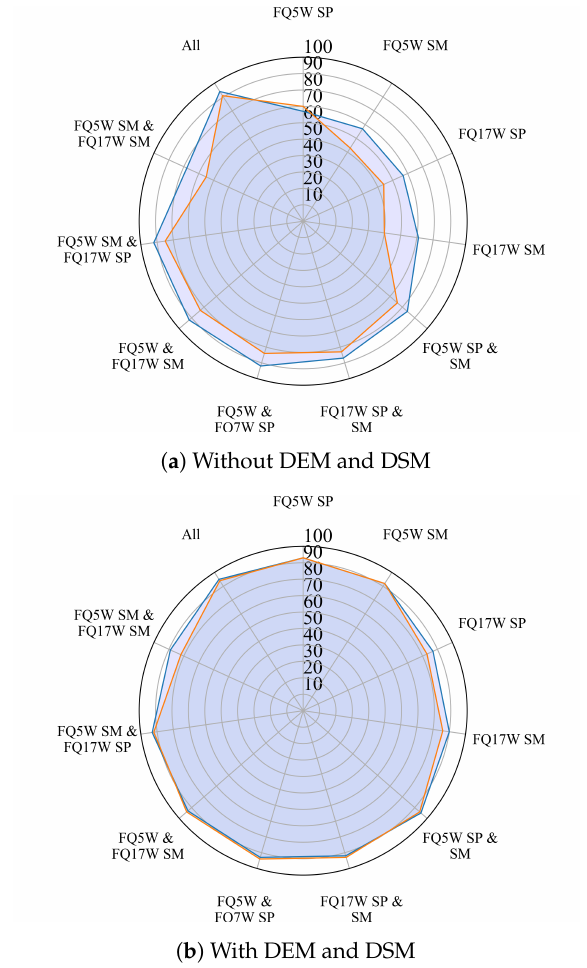
Figure 8. ( a ) shows the independent overall accuracies of wetlands for models based on just QP (blue) data, or the first simulation of high resolution CP (orange) data. ( b ) shows the independent overall accuracies of wetlands for these same models classified with the DEM and DSM data. Spring and summer acquisitions are abbreviated as SP and SM,